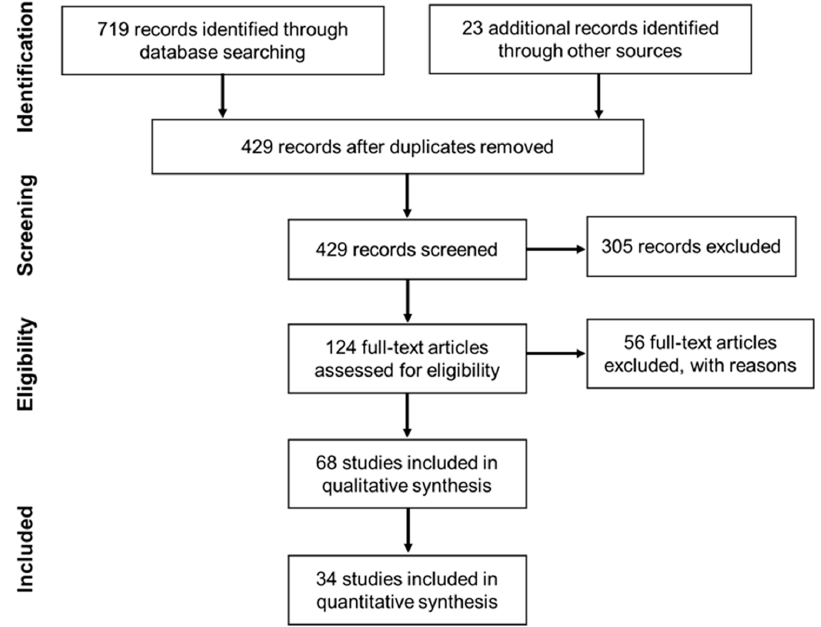
Figure 1. Flow of information through the different phases of the systematic review